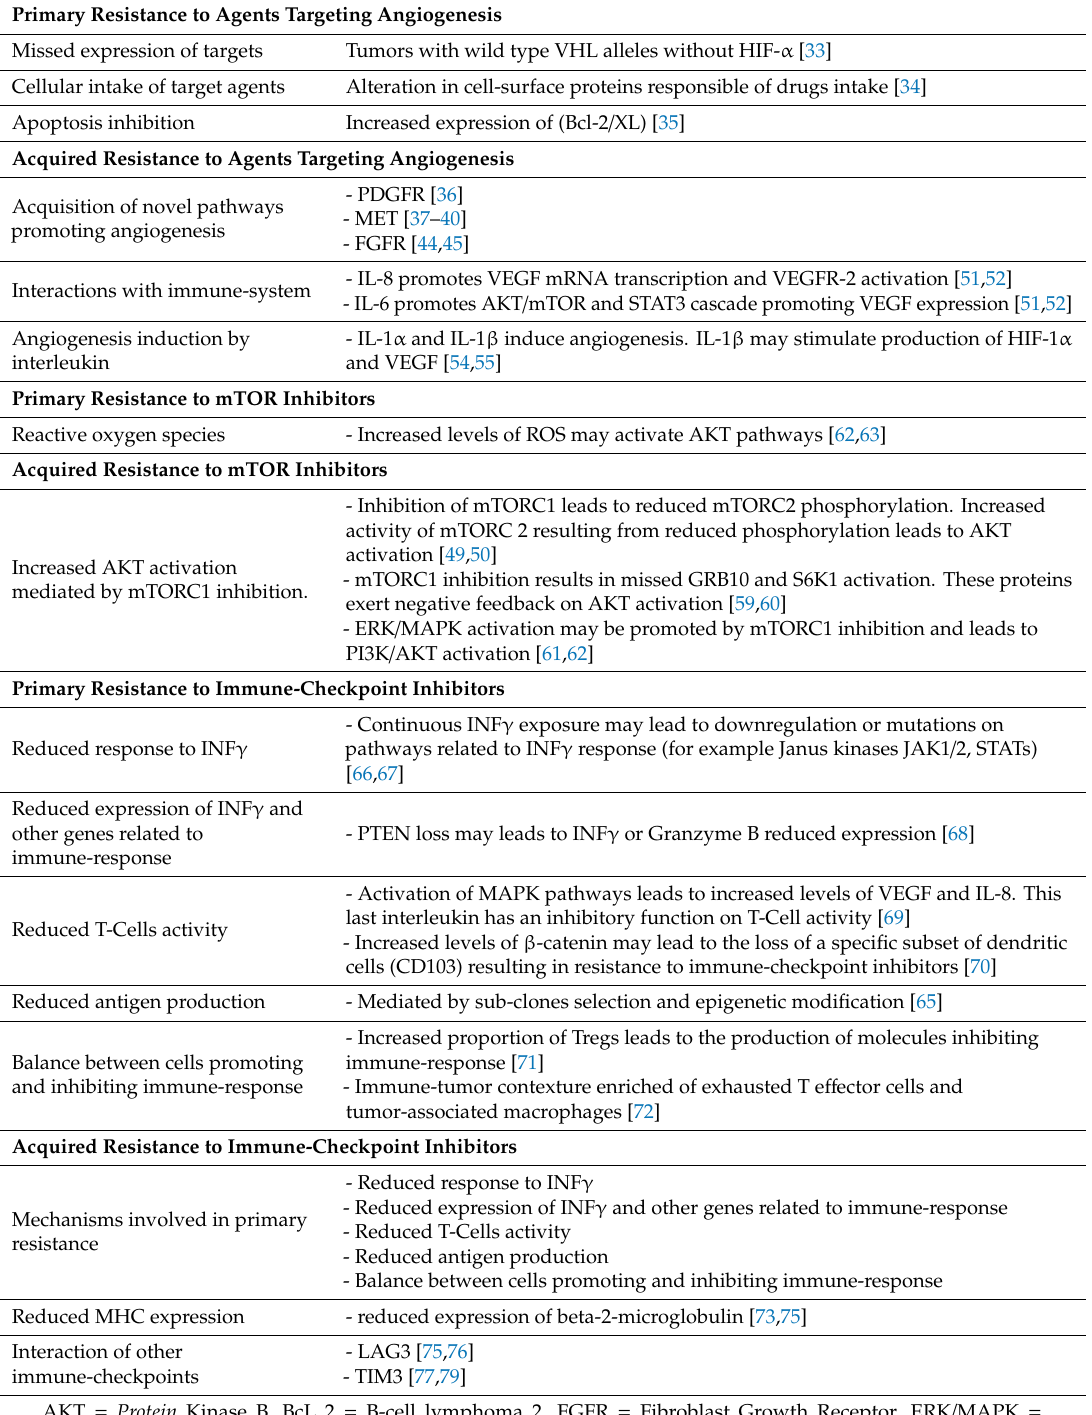
Table 1. Summary of the suggested mechanisms of acquired / primary resistance to angiogenesis inhibitors, mTOR inhibitors and immune-checkpoint